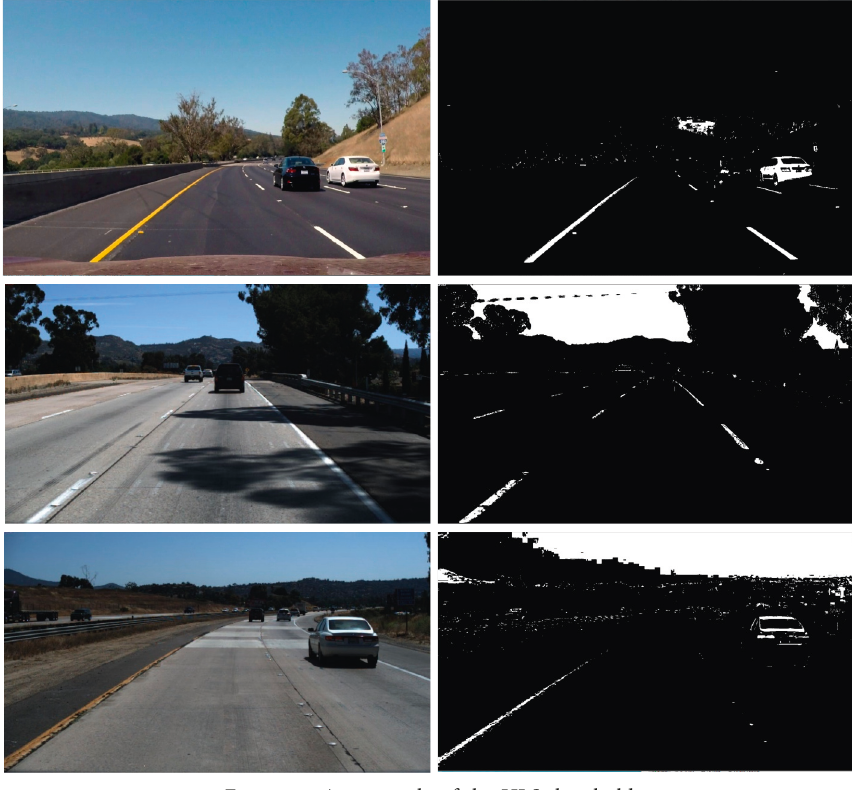
Figure 5: An example of the HLS